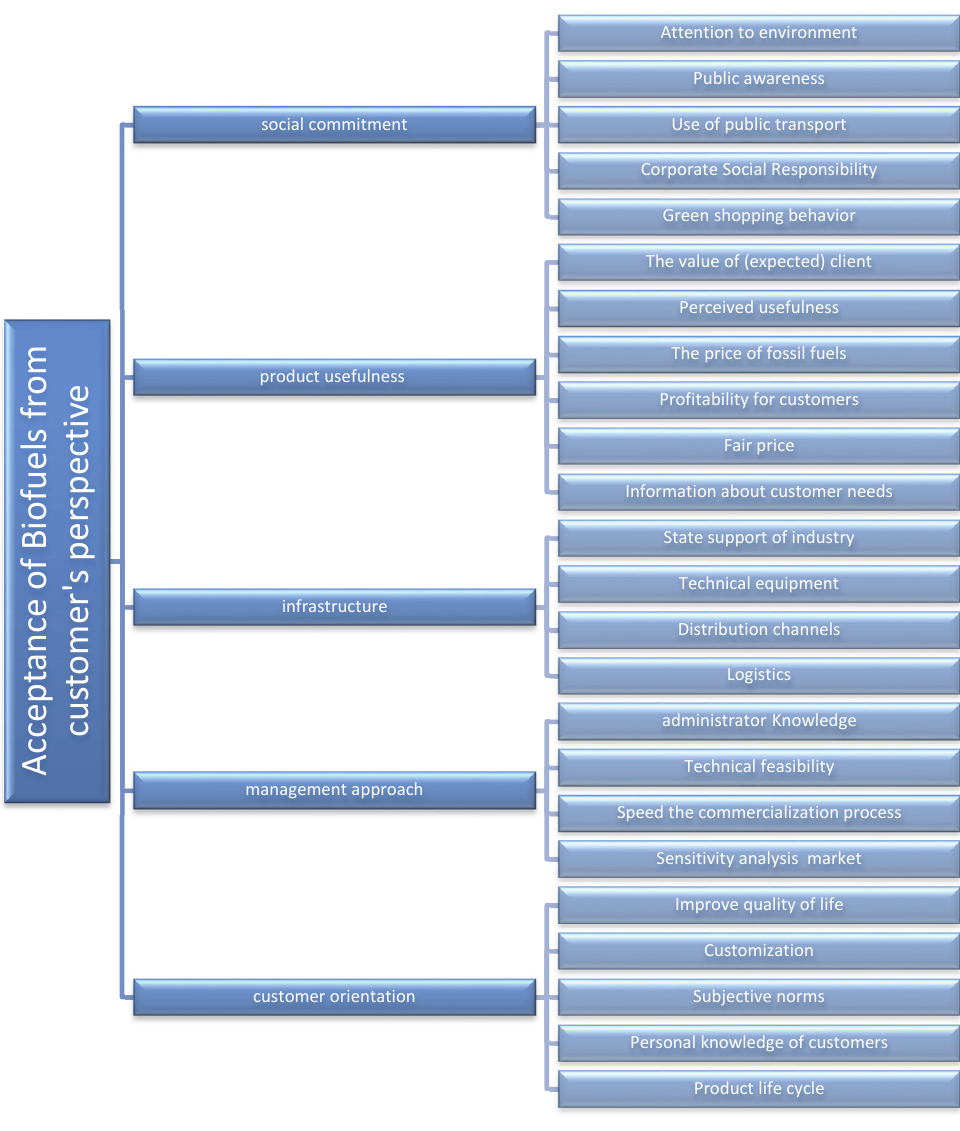
Fig. 2. The results of PCA